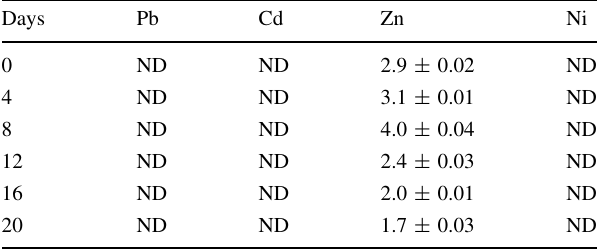
Table 3 Water-soluble metal concentrations (mg/kg dry matter)